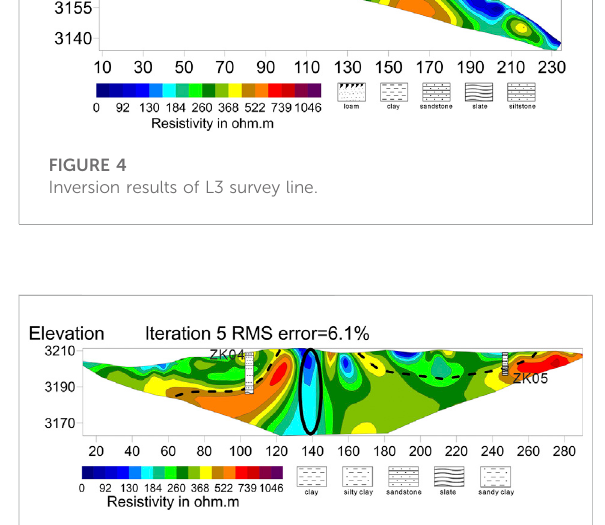
FIGURE 5 Inversion results of L4 survey line.